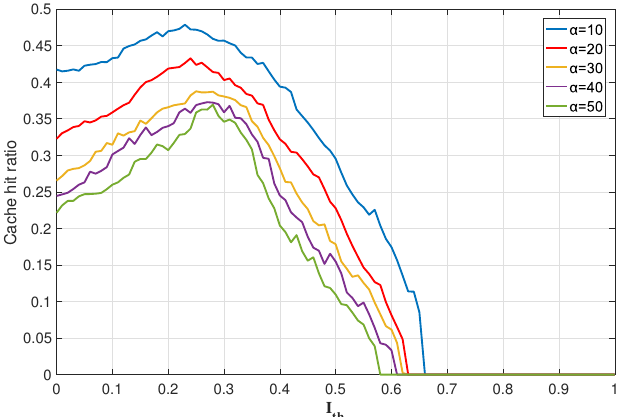
Figure 1. I th with different Poisson parameter α